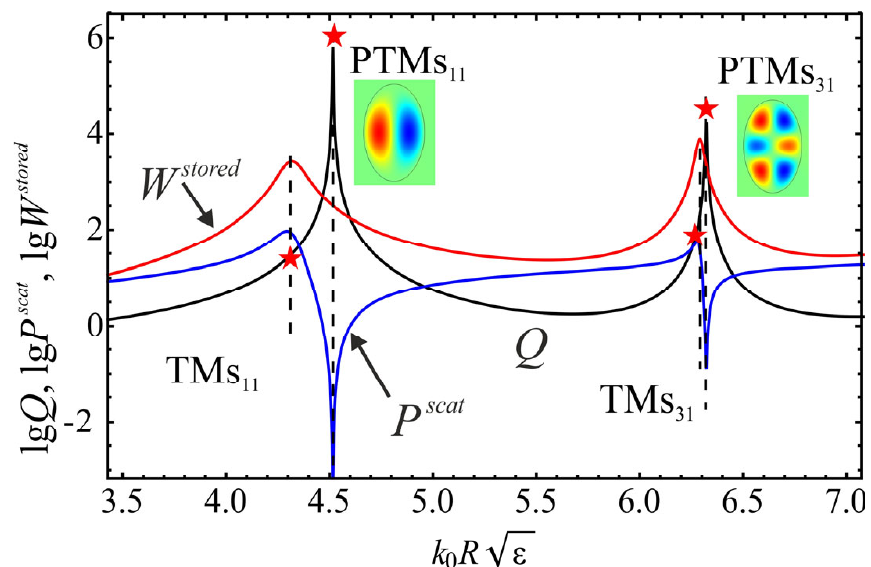
Figure 9. The dependence of scattered power lg P scat , stored energy lg W stored , and radiation quality factor lg Q ((21)) on the size parameter k R of a waveguide with a/b = 1.6 obtained with Comsol Multiphysics. The excitation field (17), α = π /4. The vertical dashed lines show the position of the mode frequencies. The asterisks on the black curve show the Q factor value of the PTMs 11 , PTMs 31 , TMs 11 , and TMs 31 modes. The insets show the H z distribution for the perfect modes.